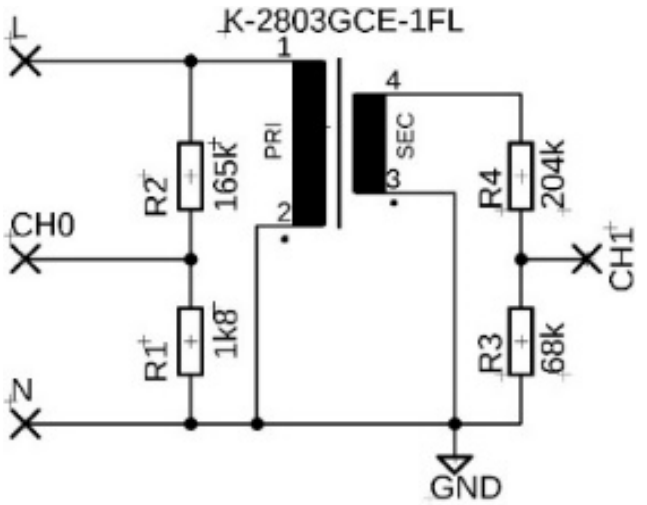
Figure 2. Measuring circuit diagram with K-2803GCE-1FL transformer.